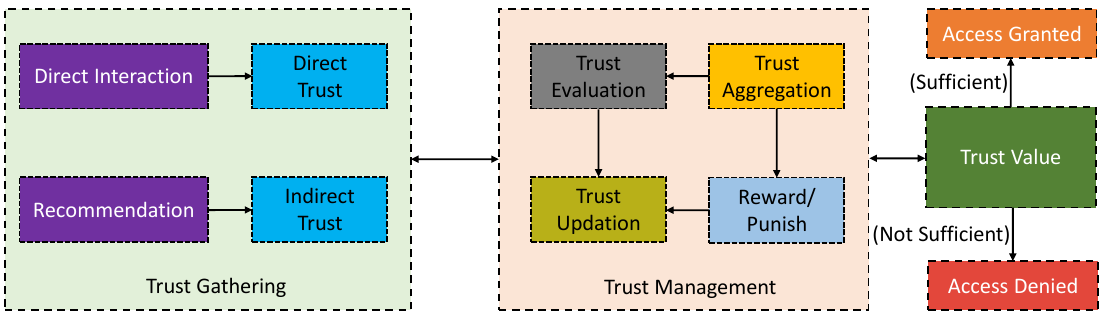
Figure 7. An outline of a simple trust management